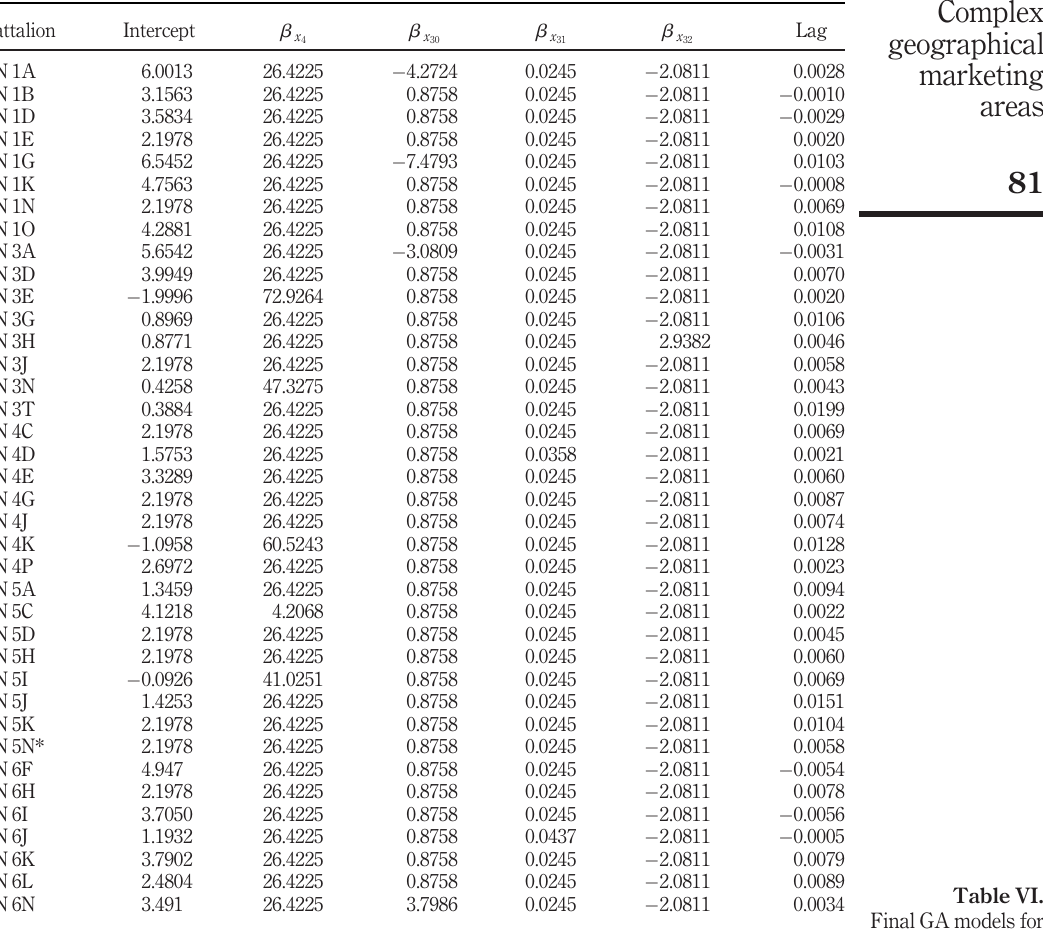
Table VI. Final GA models